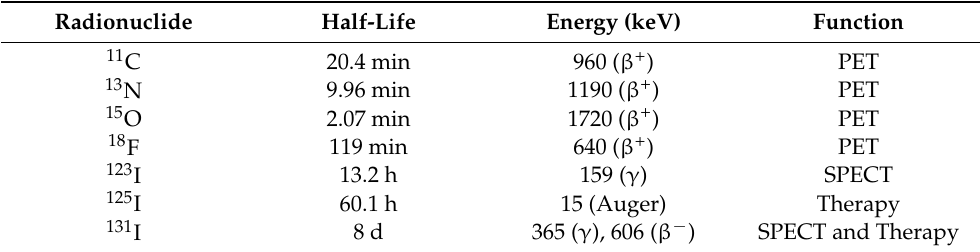
Table 1. Organic radionuclides commonly used for nuclear imaging and therapy purposes. Adapted from ref.